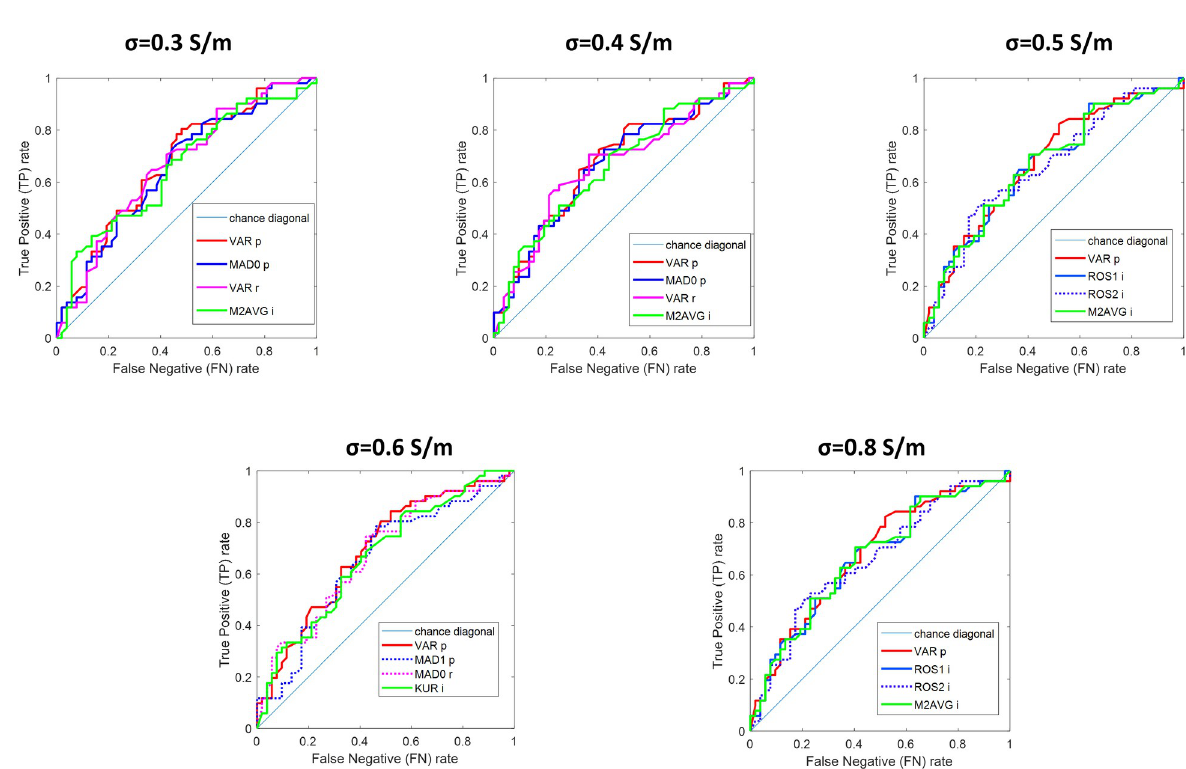
Fig 2. ROC curves of the selected features for the selected conductivity weighed images; the value of the correspondent conductivity (expressed in S/m) is given above each figure.